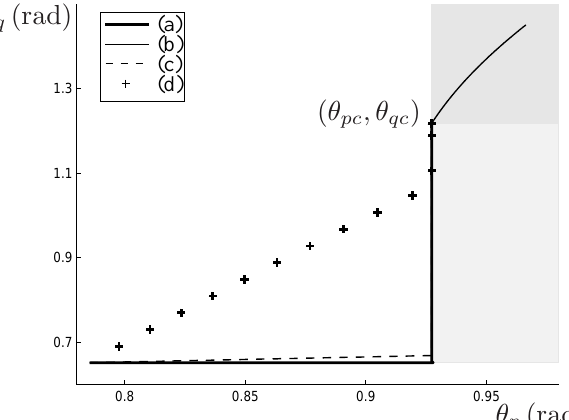
Figure 4. Configuration of the mechanism as a function of ρ 0 . Figure 5. Configurations of several mechanisms in the